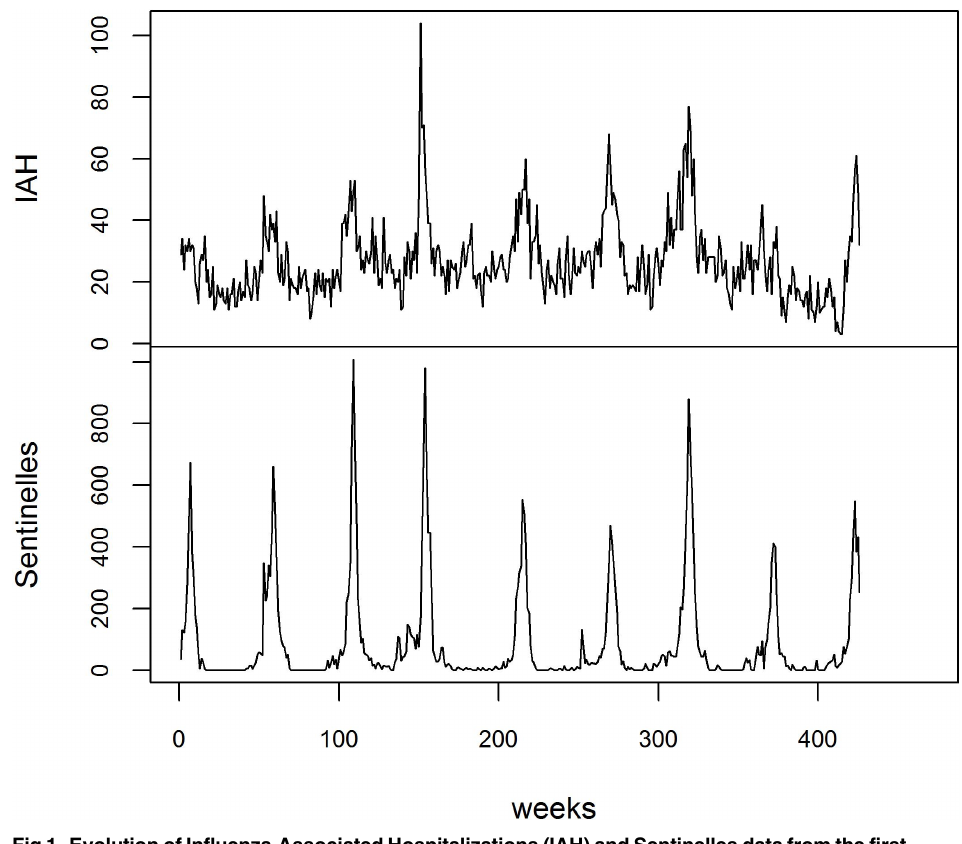
Fig 1. Evolution of Influenza-Associated Hospitalizations (IAH) and Sentinelles data from the first week of 2007 to 8 th week of 2015